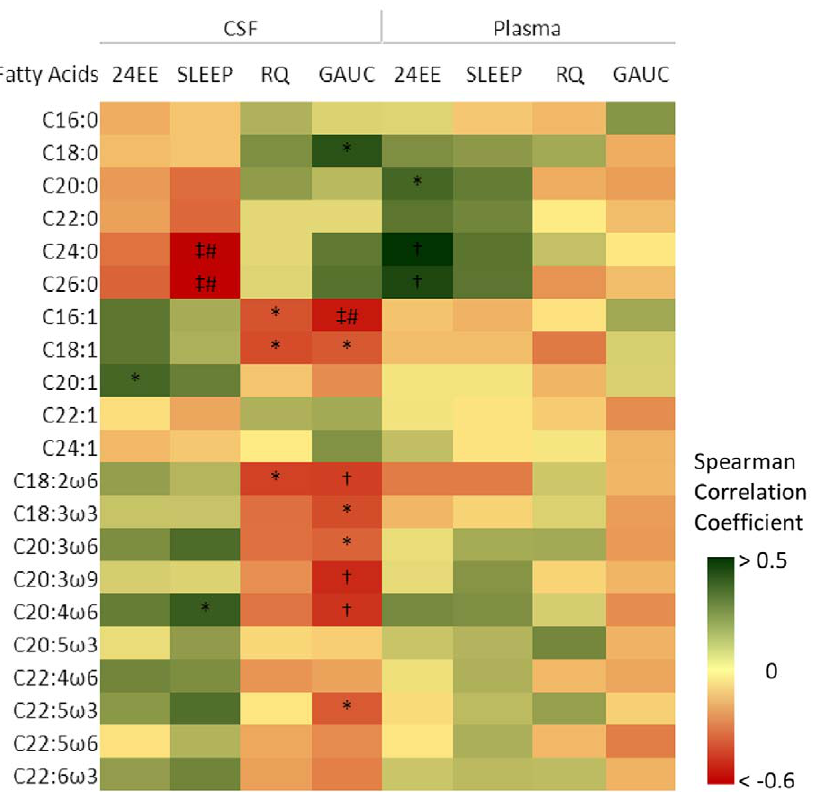
Figure 2. Correlation heatmap of fatty acid species with metabolic traits. Spearman Correlation Coefficients are represented by color codes as illustrated in the side panel. CSF: cerebrospinal fluid; 24EE: 24 hour energy expenditure measured in a metabolic chamber; SLEEP: energy expenditure measured during the sleep phase; RQ: respiratory quotient; GAUC: glucose area under the curve during the oral glucose tolerance test; *p , 0.05, { p , 0.01, { p , 0.001, # significant after Bonferroni correction.